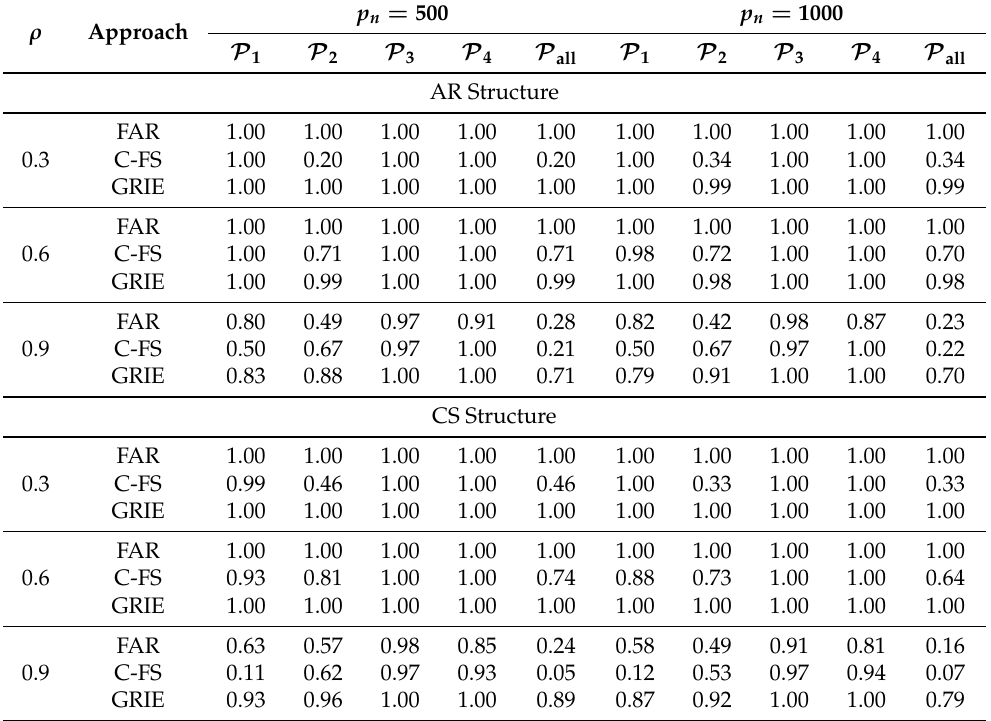
Table 3. The empirical probabilities of each important covariate and all important covariates being retained for 100 replications in Example 1 with (cid:101) ∼ N ( 0,1 )